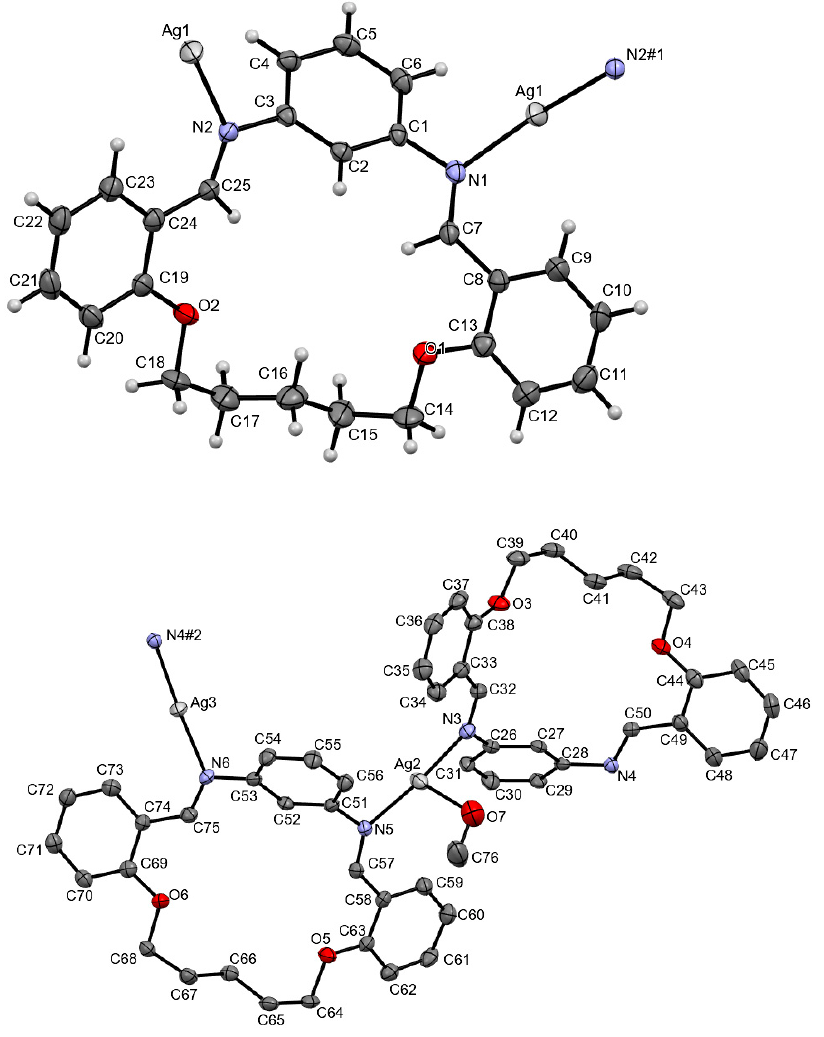
Figure 3. ORTEP plot of AgLPF 6 with displacement ellipsoids of non-hydrogen atoms drawn at the 50% probability level. Symmetry operation: #1 − 1/2 + x, 3/2 − y,1 − z, #2 − 1 + x, +y, +z. Hydrogen atoms, solvent methanol molecule, and PF 6 are omitted for the sake of clarity.